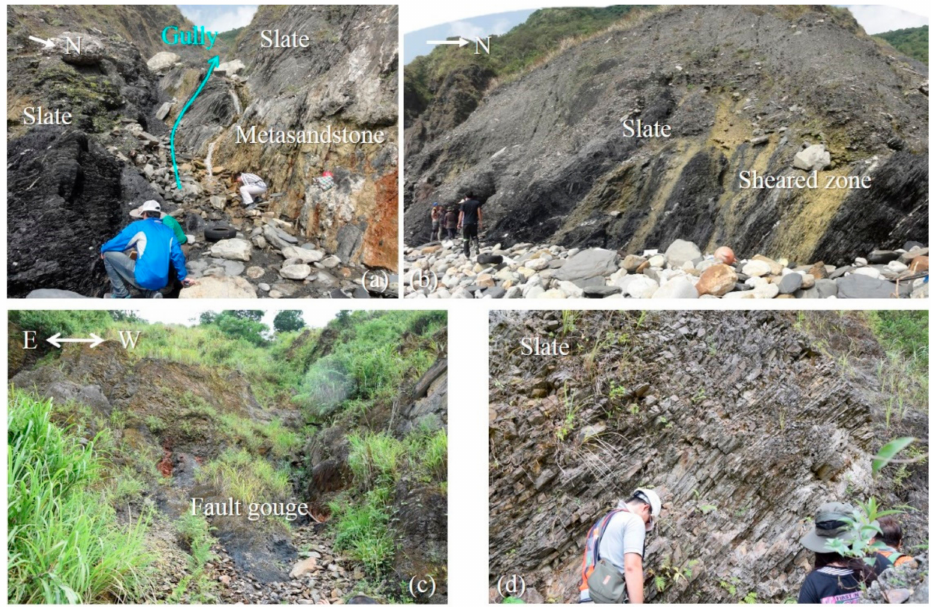
Figure 7. On-site investigation of the Houishan Fault. Images taken near the erosion gullies on the eastern coast ( a , b ) and the left bank slope of the Zuntoukeng River ( c , d